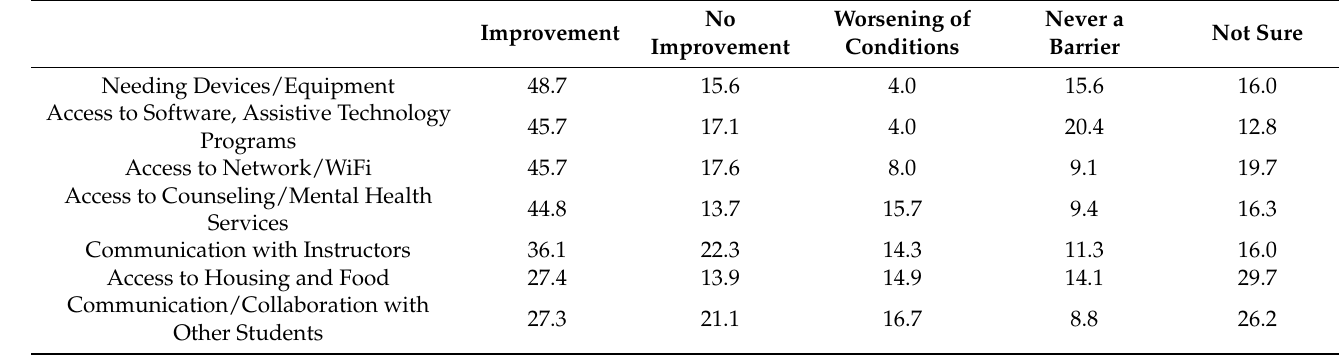
Table 4. Disability resource professionals’ perceived barriers for students with disabilities during COVID-19 (nine months into pandemic, n = 631), by percent.